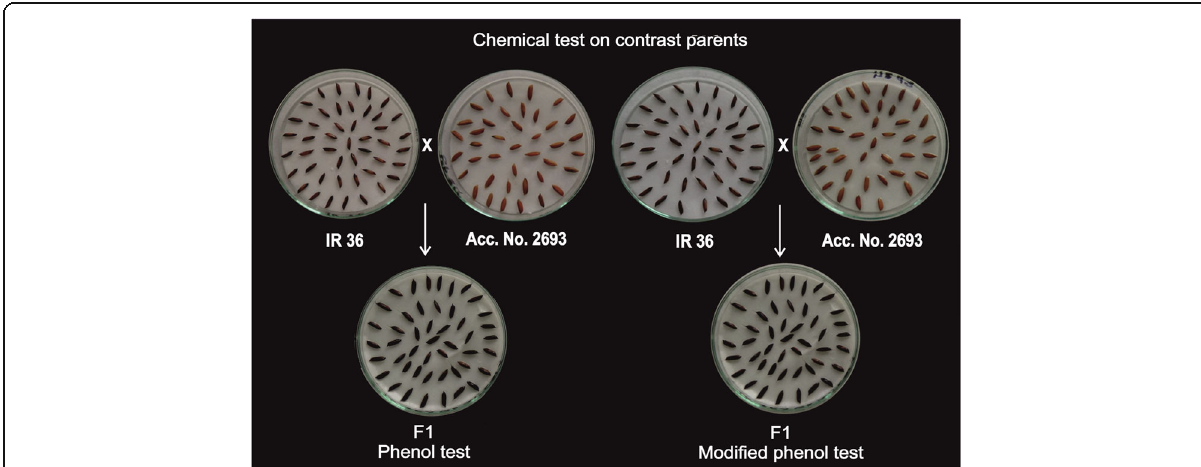
Fig. 2 Colour formation in aleurone layer of parents IR 36 (brown colour), Acc. No. 2693 (light brown/no reaction) and their F 1 progeny (brown colour) with phenol and modified phenol